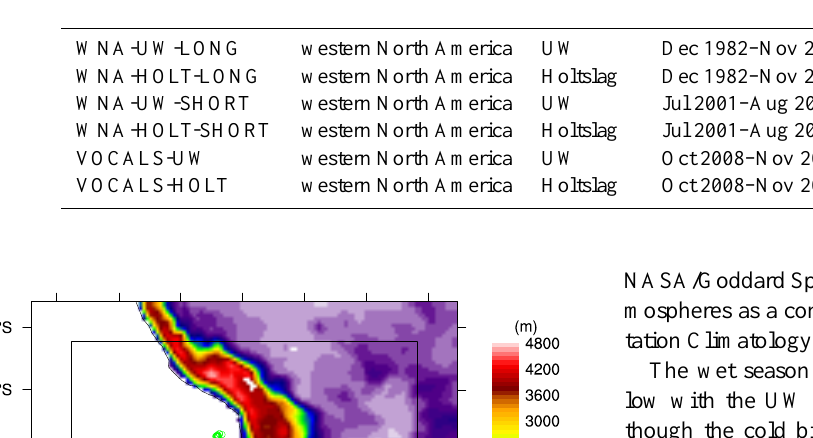
Table 1. A list of the various RegCM runs used in this study and their relevant parameters. Domain Abbrev.